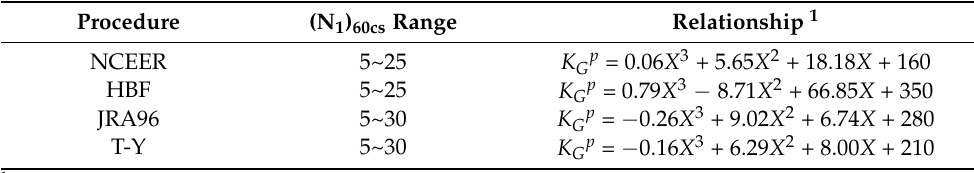
Table 6. Calibrated K Gp of the UBCSAND